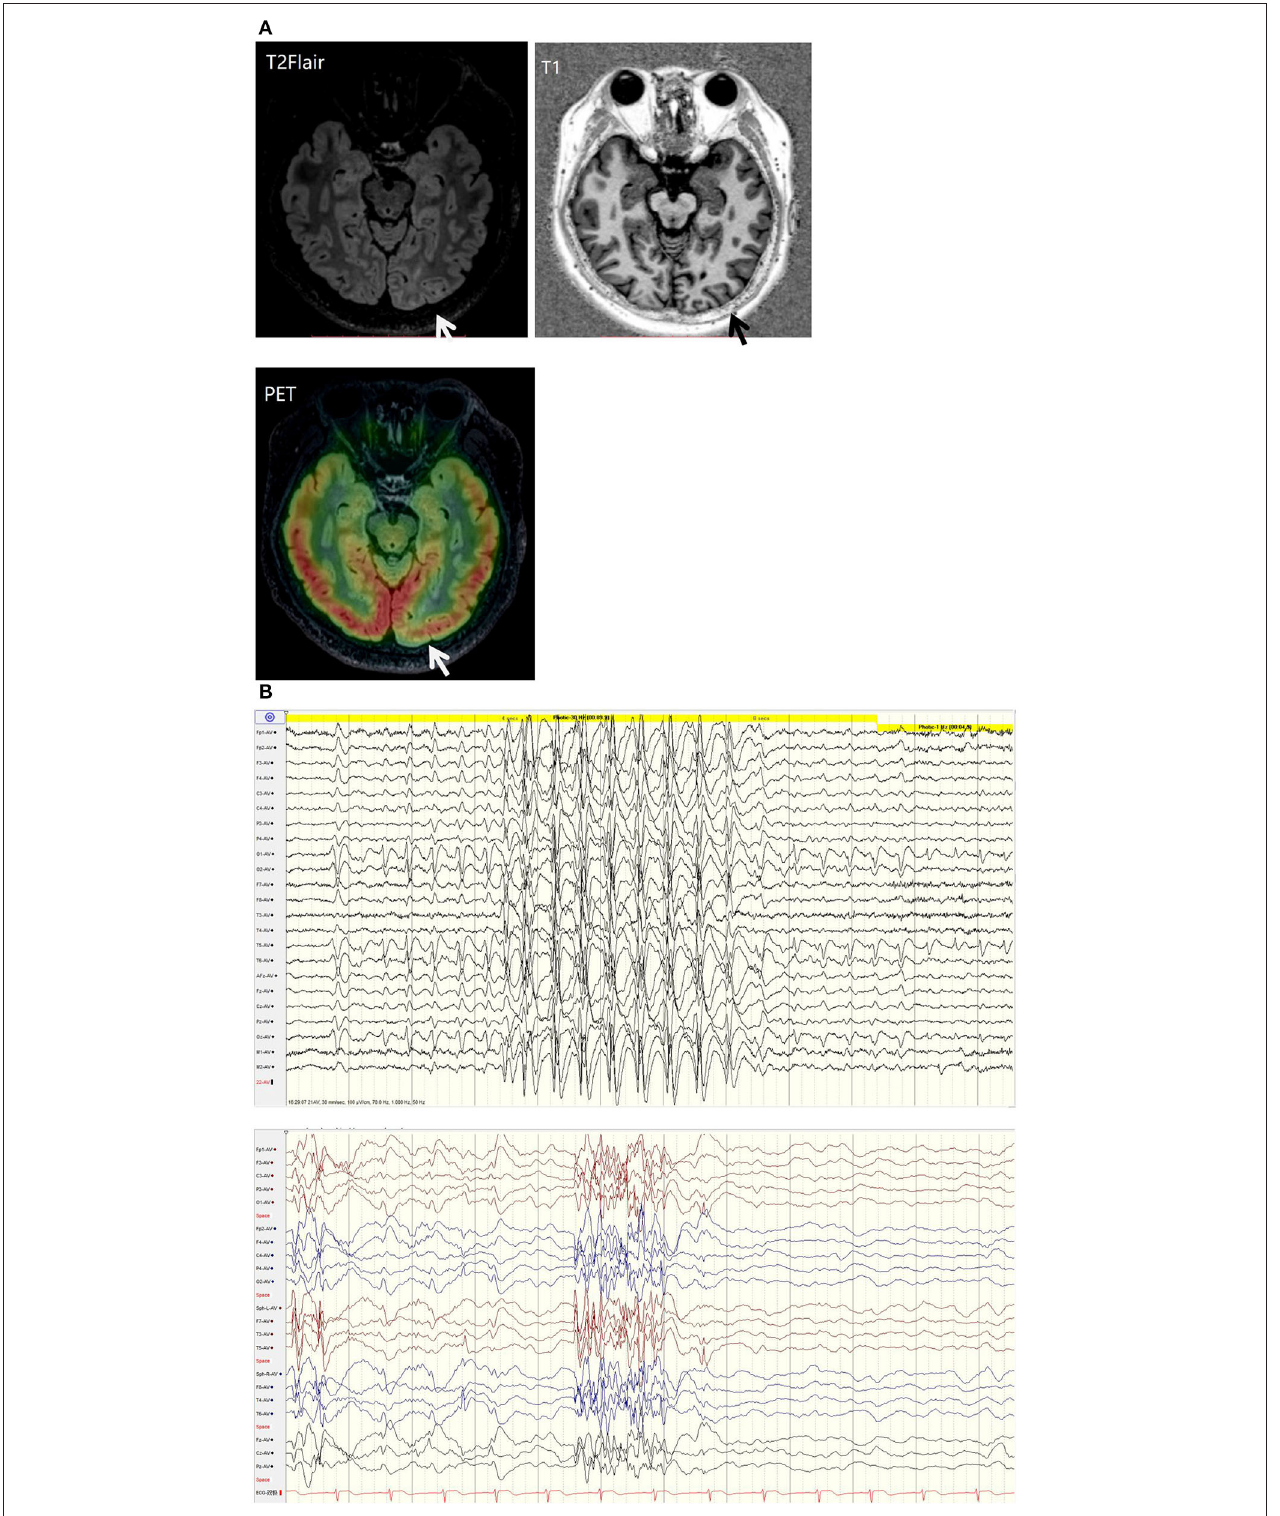
FIGURE 1 | (A) T2 fluid-attenuated inversion recovery (T2-FLAIR) magnetic resonance imaging showing a suspiciously unclear gray-white matter boundary around the left calcarine sulcus (white arrow). T1 magnetic resonance imaging showing a suspiciously unclear gray-white matter boundary around the left calcarine sulcus (black arrow). Positive emission tomography showing low metabolism at the cortex around the left calcarine sulcus (white arrow). (B) EEG background: generalized 2-2.5 Hz slow spike waves (SSWs) during wakefulness and generalized paroxysmal fast activity (GPFA) during sleep.